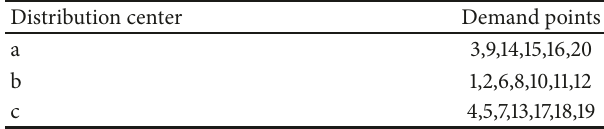
Table 4: Demand points clustering